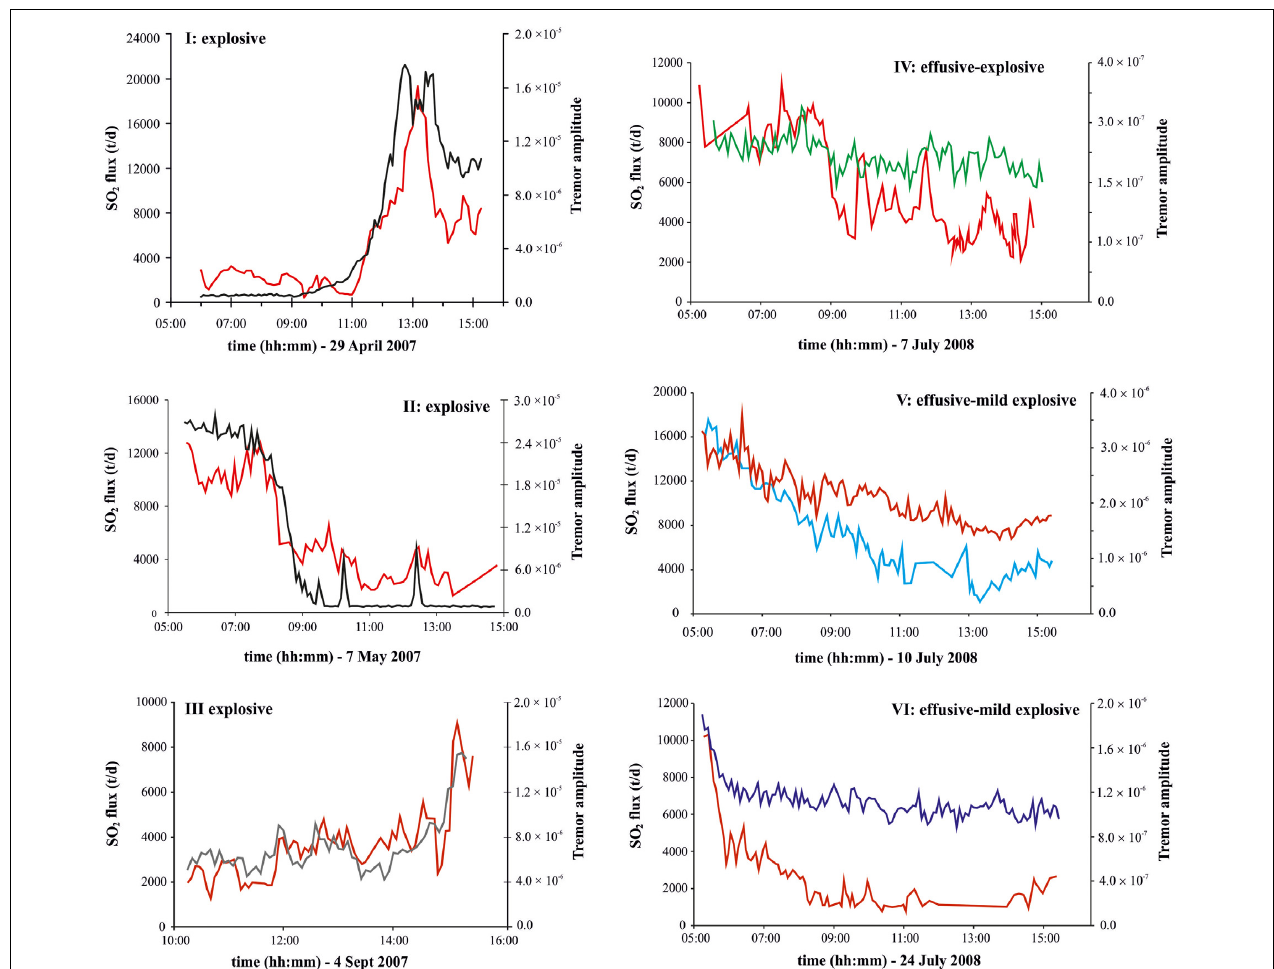
FIGURE 3 | Intraday SO 2 flux and volcanic tremor amplitude for the selected case studies ( Table 1 ). In the six cases, tremor mirrored SO 2 outgassing in different eruptive style and transition. SO 2 flux (red line) was strongly correlated with volcanic tremor at frequency band with max correlation clustered in two groups of high (black line) and medium-low frequency (gray, green, cyan, and blue